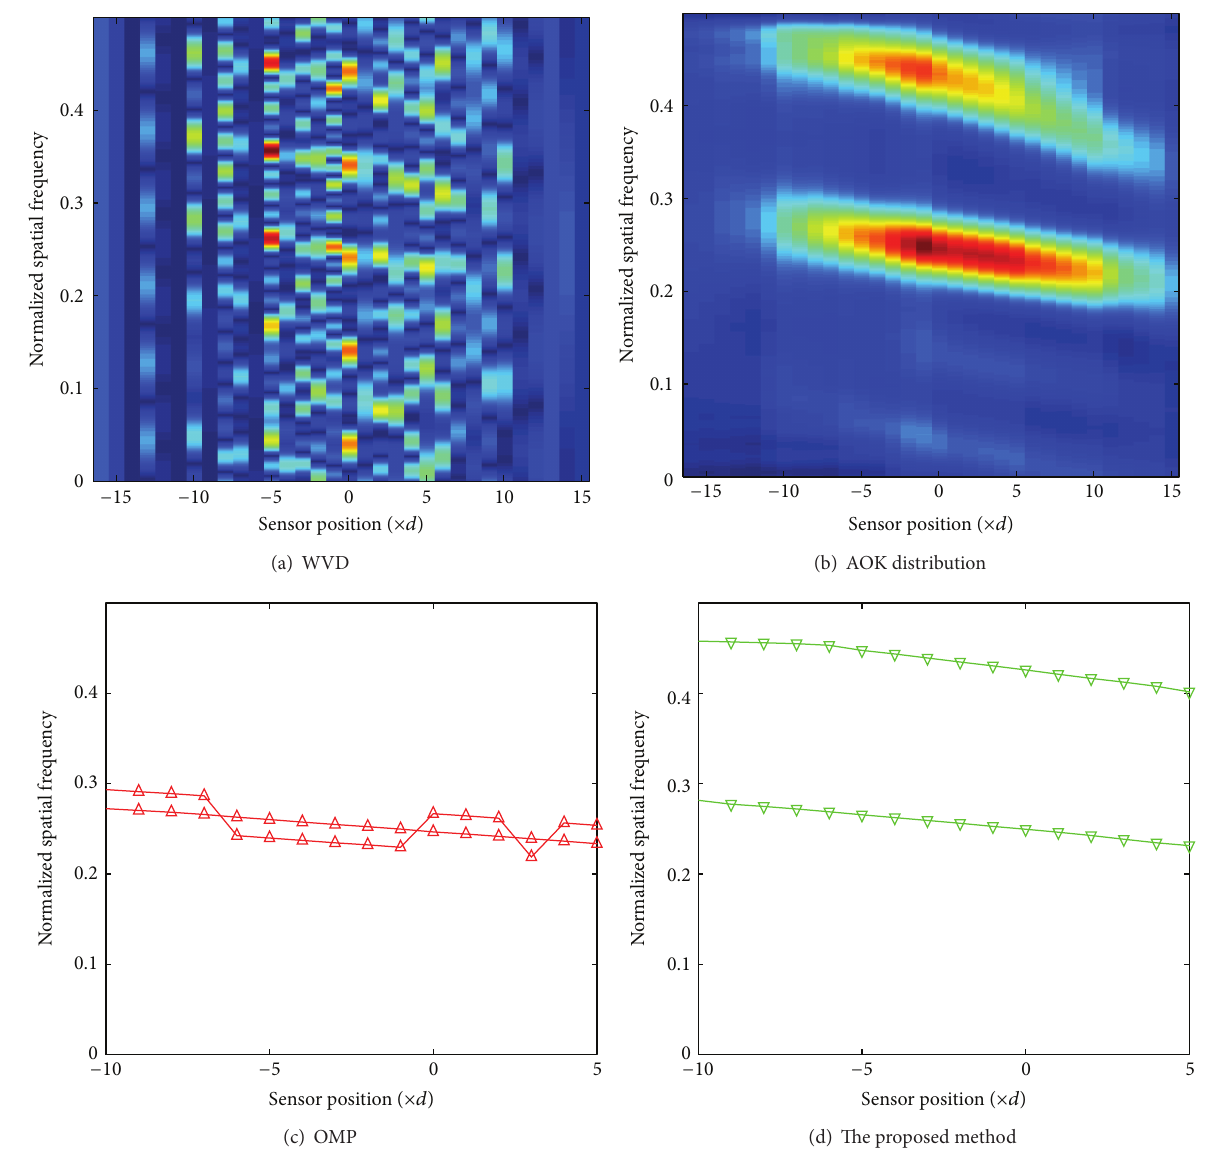
Figure 11: Near-field source location estimation using the sparse array ( 𝑟 1 = 300 m, 𝜃 1 = 30 ∘ and 𝑟 2 = 1000 m, 𝜃 2 = 60 ∘